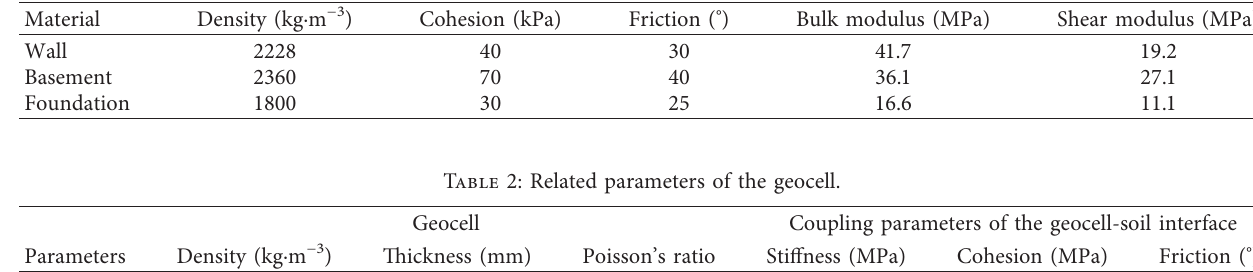
Table 1: Calculation parameters of soil.